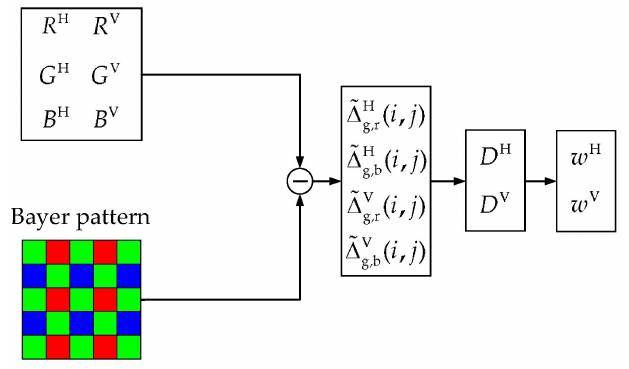
Figure 5. The calculation process of the directional